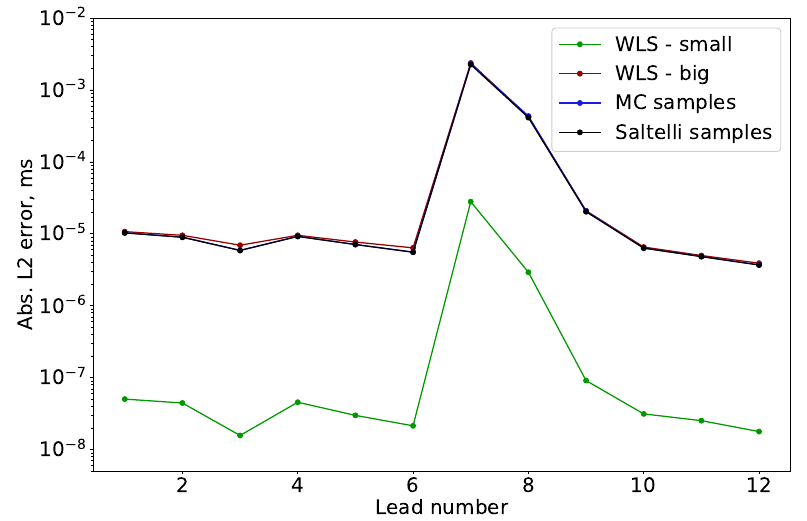
Figure 3. Absolute L2 error estimates (cf. Equation (11)) for the PCE surrogates of the four different datasets with polynomial order p = 6. Note that the differences between the three different sam- pling schemes, optimized for weighted least-squares (WLS, red), a standard Monte–Carlo sampling (MC, blue) and the Saltelli sampling scheme (black) yield very similar values of the approximation accuracy. The surrogate with smaller input parameter variability (halved interval width in each of the 8 input dimensions around the same mean value, shown in green) gives significantly smaller approximation errors. When further comparing it with the inter-lead variation in Figure 2, it becomes clear that the smaller signal variance, rather than a difference in (mean) signal strength, determines approximation